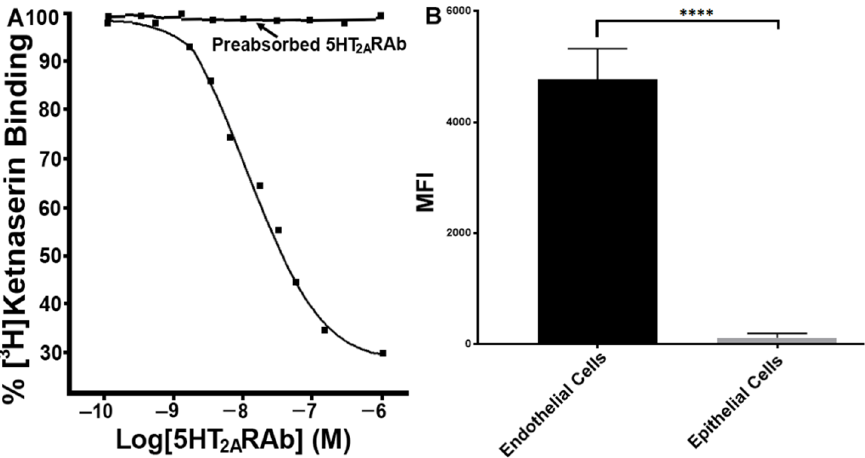
Figure 1. The 5HT 2A RAb displaces the 5HT 2A R antagonist [ 3 H]ketanserin from its binding sites and binds to endothelial cells but not epithelial cells. ( A ) Binding displacement of the radiolabeled 5HT 2A R antagonist [ 3 H]ketanserin (2 nM) with increasing concentrations of 5HT 2A RAb (10 nM–1 µ M) in human platelets; and preabsorption of 5HT 2A RAb with its cognate peptide reversed its ability to displace binding of ketanserin from the 5HT 2A R. ( B ) Flow cytometry binding of the 5HT 2A RAb to endothelial cells and epithelial cells (**** p < 0.0001). These experiments were repeated three times, with blood obtained from three separate healthy human donors, or three separation preparations of endothelial cells and epithelial cells.